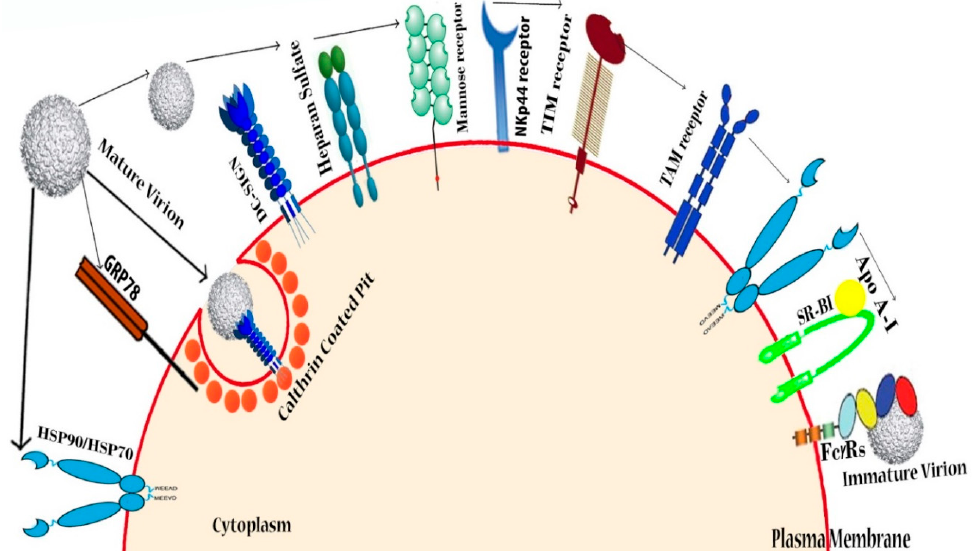
Figure 3. DENV receptors in human cells: DENV recognizes various types of receptors present in the host cells. Heparan sulfate was identified as the first molecule responsible for DENV entry into mammalian cells, while sulfated glycosaminoglycans—ubiquitous molecules on the cell surface—were found to play a role in mediating DENV attachment. CLEC4L (C-type lectin domain family 4, member L), CLEC4M (C-type lectin domain family 4, member M), and mannose receptor / CLEC13D /